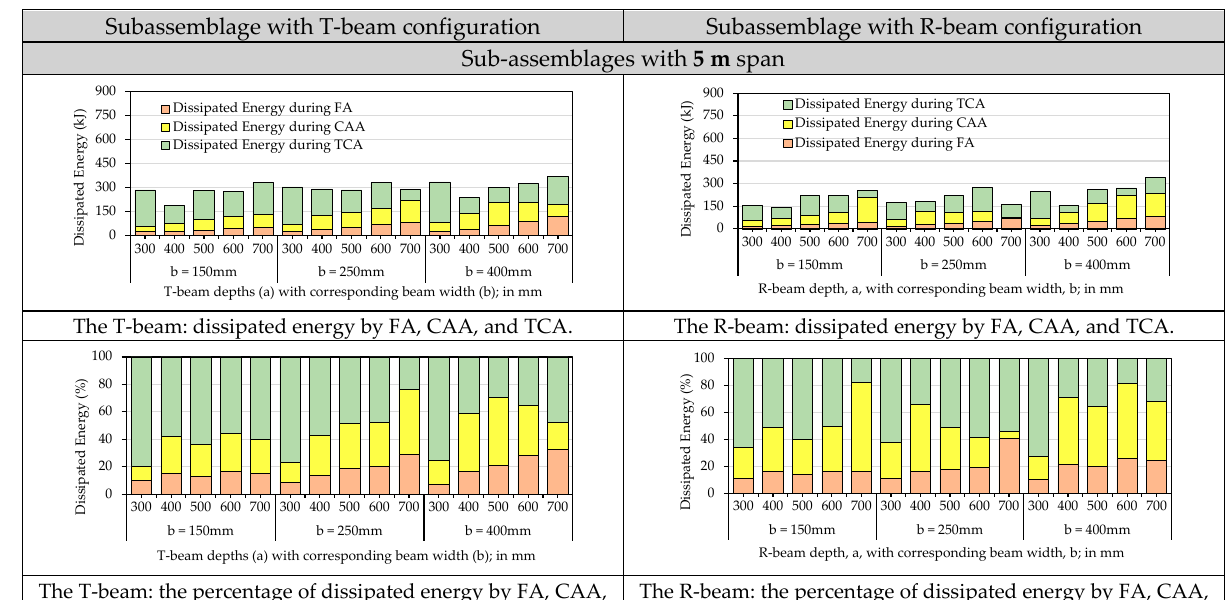
R-beam depth, a, with corresponding beam width, b; in mm The R-beam: the percentage of dissipated energy by FA, CAA, and TCA.